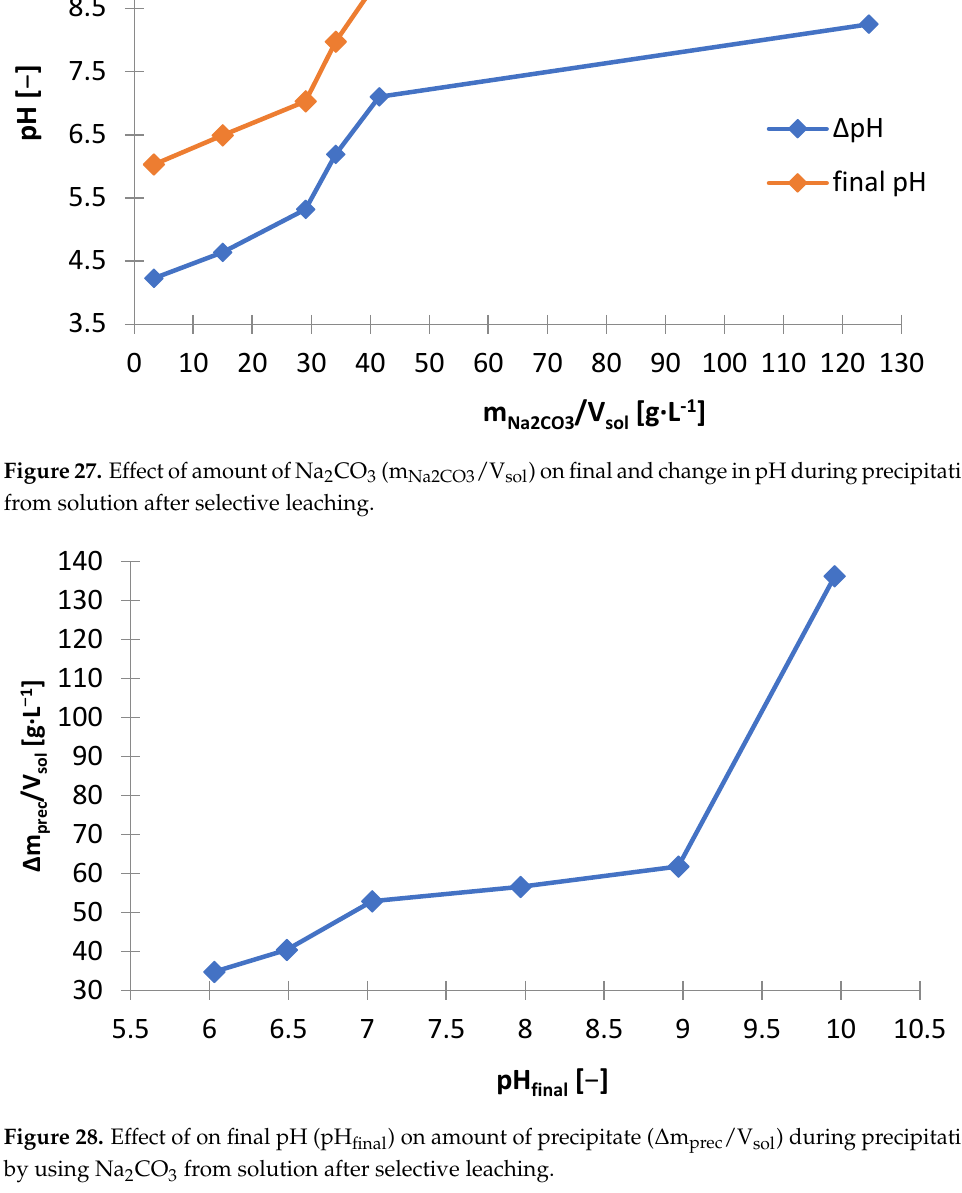
Figure 28. Effect of on final pH (pH final ) on amount of precipitate ( ∆ m prec /V sol ) during precipitation by using Na 2 CO 3 from solution after selective leaching. The colors of the obtained precipitates were different depending on the final pH: 6—white; 6.5—gray; 7—black; 8–10—from dark to light brown. Figures 30 and 31 show the chemical composition and amounts of elements in the precipitates in relation to initial solution volume, respectively. At pH = 6, the precipitate had the highest concentration of sulfur, i.e., 25.8 wt.%, and a certain content of potassium, manganese and zinc (respectively: 5.4, 11.8 and 55.2 wt.%). The composition changed at pH = 6.5: sulfur—7.2; Mn—4.6; Zn—85.7 wt.%; the precipitate had the highest zinc content at this pH. Increasing the